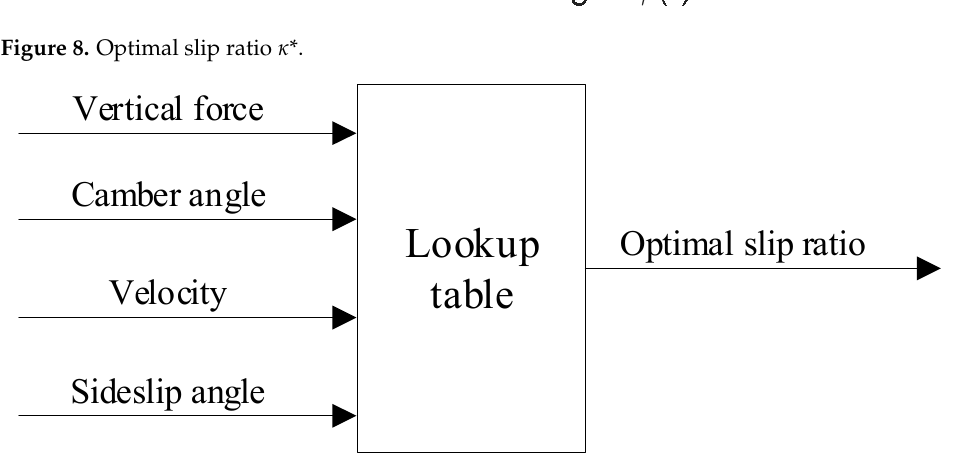
Figure 8. Optimal slip ratio κ *.